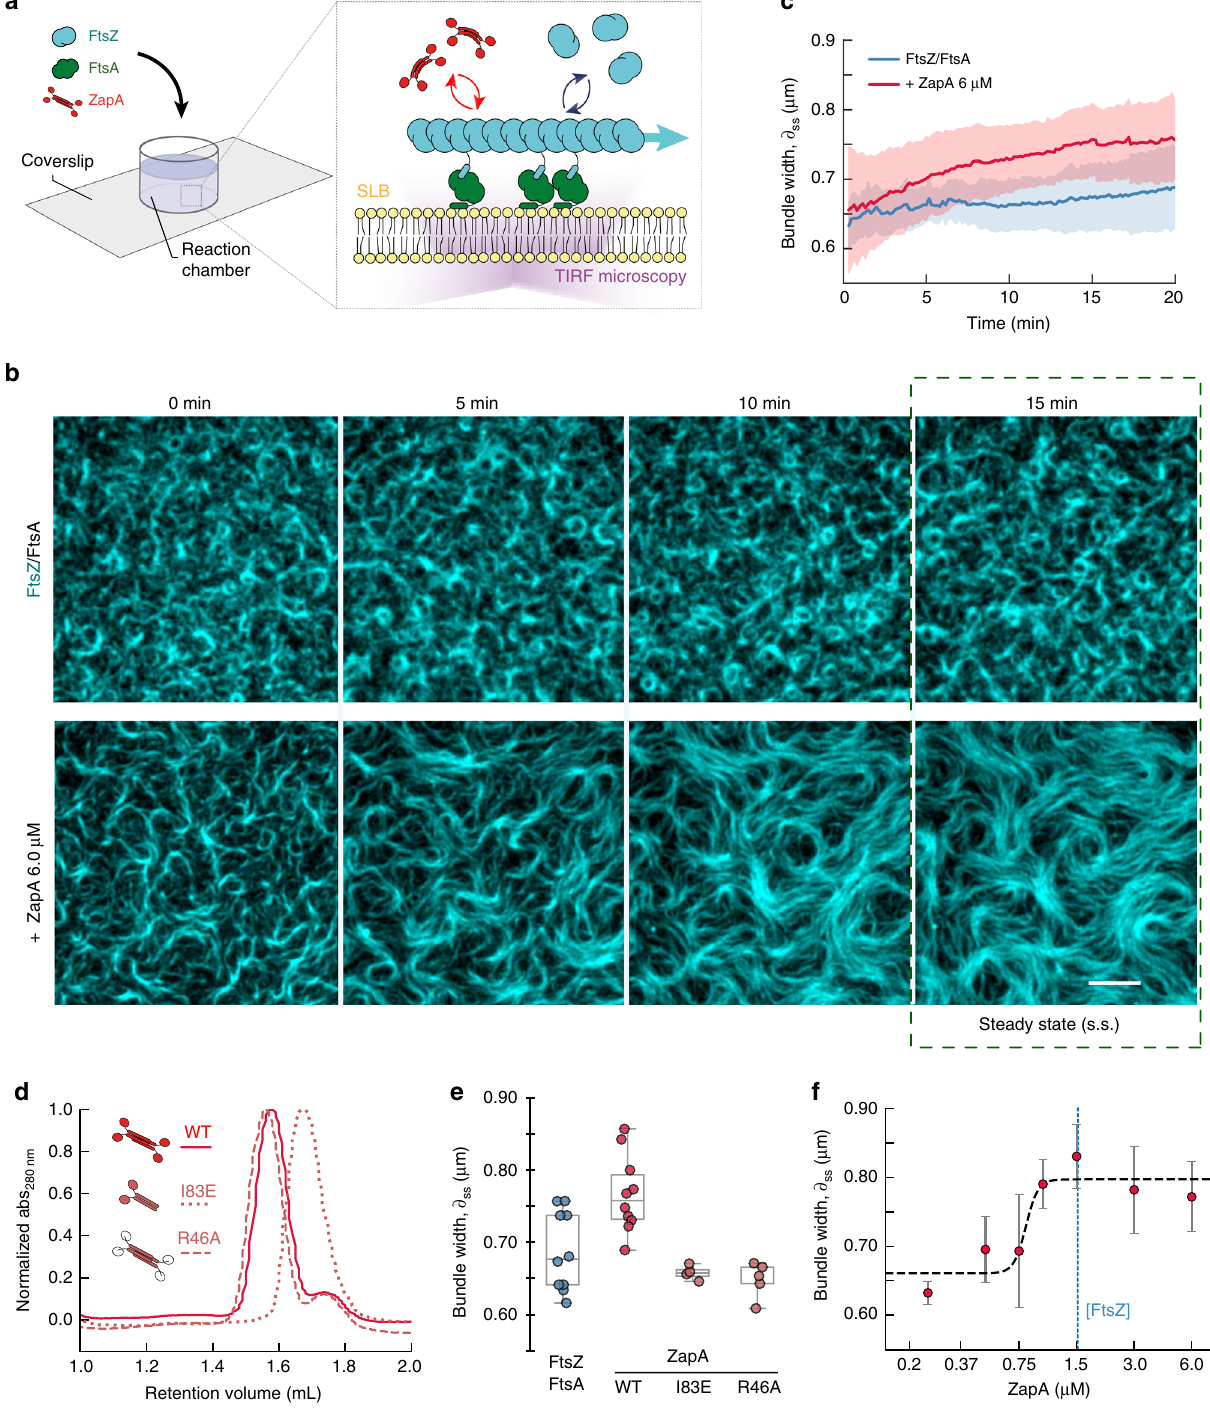
Fig. 1 ZapA increases the width of membrane-bound FtsZ fi lament bundles. a Illustration of the experimental assay based on a supported lipid bilayer, puri fi ed proteins and TIRF microscopy. b Snapshots of FtsZ pattern emerging from its interaction with FtsA alone (top row) and in the presence of 6 μ M ZapA (lower row). Concentrations of FtsZ (30% Cy5-labelled) and FtsA were kept constant for all experiments (1.5 μ M and 0.5 μ M, respectively). Scale bars, 5 μ m. c Estimated mean bundle width, δ , over time for FtsZ/FtsA fi lament pattern (blue) and with 6 μ M ZapA (red). Curves depict the mean and the standard deviation (std) as shaded error bands of independent experiments (FtsZ, n = 10, ZapA, n = 10). d Size-exclusion chromatography results for ZapA wild type (WT) and mutants (ZapA I83E, ZapA R46A). e Mean bundle width, δ ss , of membrane-bound FtsZ fi laments is increased in the presence of 6 μ M ZapA (red) (two-tailed t test with p = 0.004) while it was unchanged in the presence of ZapA I83E and ZapA R46A (light red) ( p > 0.05). f Change in δ ss with varying concentrations of ZapA. Data shown (steady state) corresponds to the average bundle width measured between t = 15 min and t = 20 min (mean ± std). Black line corresponds to Hill equation fi t with n H = 13.86 and EC 50 = 0.81 μ M with 90% con fi dence intervals of [13.86 – 94.68] and [0.71, 0.98], respectively, obtained from bootstrapping distributions. Source data available at Figshare [https://doi.org/10.6084/m9. fi